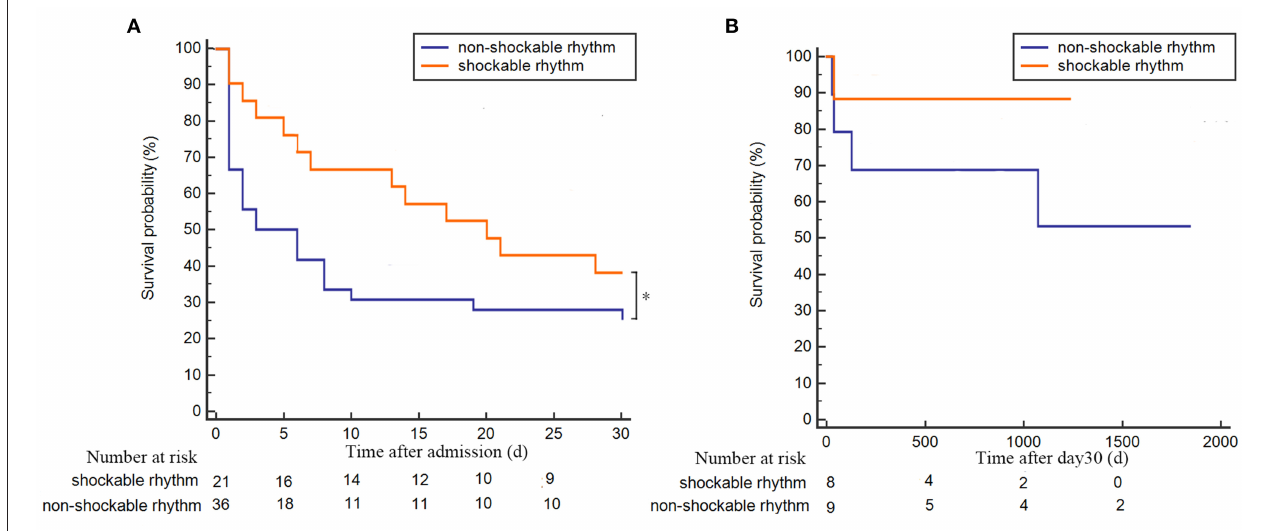
FIGURE 4 | Kaplan–Meier plot of survival probability for POCA patients with shockable or non-shockable rhythm. (A) 30-day follow-up survival curve for POCA patients with shockable rhythm (orange line) or non-shockable rhythm (blue line); (B) long-term follow-up survival curve of POCA patients with shockable rhythm (orange line) or non-shockable rhythm (blue line) in 30-day survivors. * p < 0.05. POCA, post-revascularization cardiac arrest; PRCA, pre-revascularization cardiac arrest.